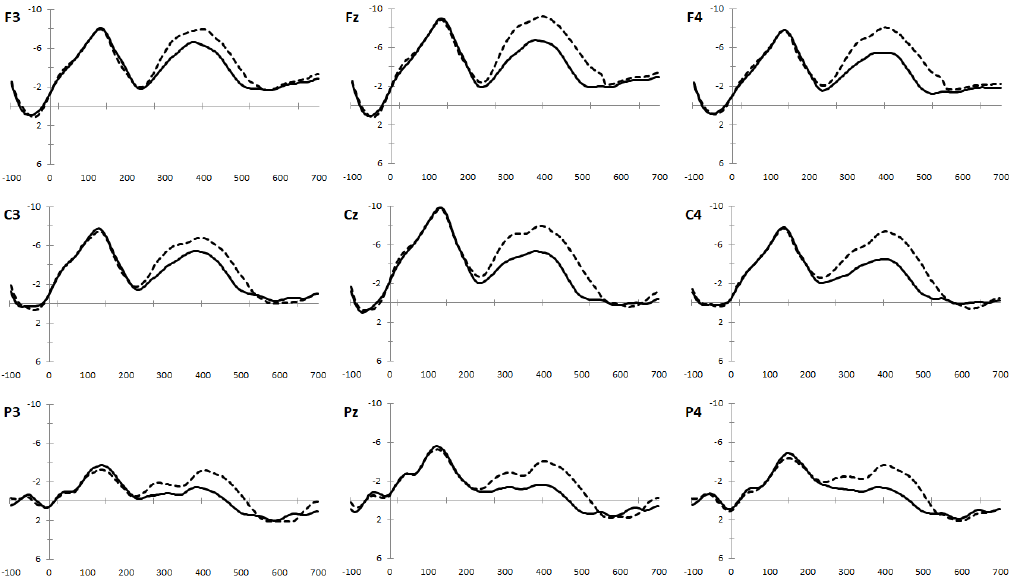
Figure 2. Grand average ERP waveforms for semantically unrelated (dotted lines) and semantically related words (solid lines) in Experiment 1. ERPs are plotted for nine equidistant representative electrodes within each region of interest. Negative voltage is plotted up. Onset of the Spanish word (i.e., the target) is indicated by the vertical calibration bar. Data are plotted from 100 ms prior to and 700 post stimulus onset.